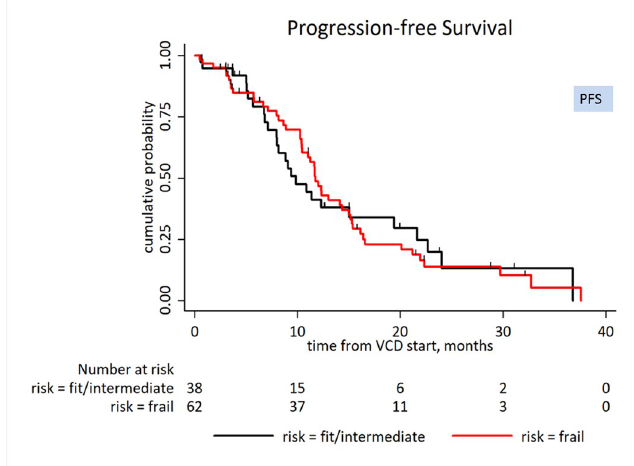
Fig 3. Progression-free survival (PFS) by frailty (frail vs. intermediate or fit): (11.8 vs. 9.9 months, HR: 0.99, 95% CI: 0.61–1.61, P = 0.982).